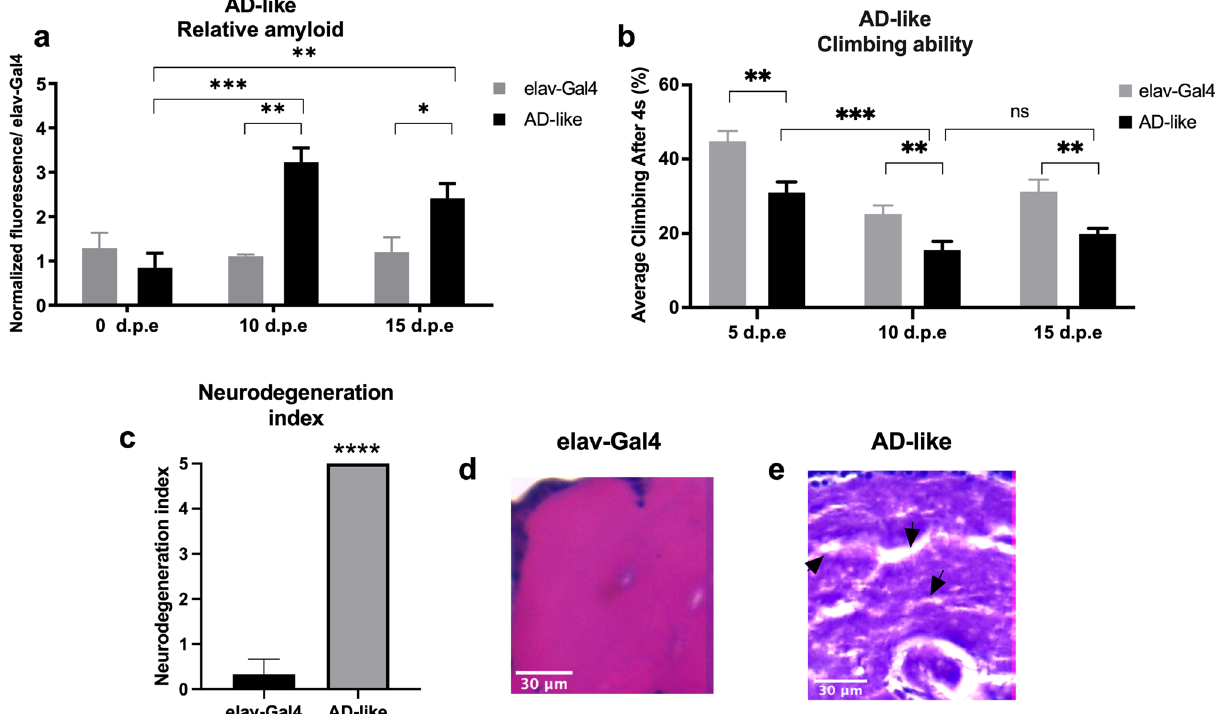
Figure 1. AD-like flies show a degenerative phenotype. ( a ) Amyloid quantification through Thioflavin aggregation assay. AD-like flies presented a higher amyloid content when compared to control flies (elav-Gal4) at 10- and 15-days post eclosion (d.p.e.) (n = 20 in each genotype). ( b ) Climbing ability. AD-like flies presented a lower climbing ability in the RING assay than the control genotype at 5–8, 10–13, and 15–18 days post eclosion. AD-like flies present a climbing ability decrease when comparing flies at 5–8 and 10–13 d.p.e. (n ≥ 180 in each genotype). ( c ) Neurodegeneration index of elav-Gal4 (control) and AD-like flies based on histopathology analysis, according to vacuolar lesions. 0 indicates no lesions, and 5 indicates neurodegenerative phenotype (n = 10, at 10 days after treatment). Data are shown as the mean ± S.E.M. The statistical significance is indicated as ** for P < 0.01 and *** for P < 0.001 (two-tailed ANOVA). Illustrative images of ( d ) elav-Gal4 and ( e ) AD-like flies’ histopathology. Arrows indicate vacuolar